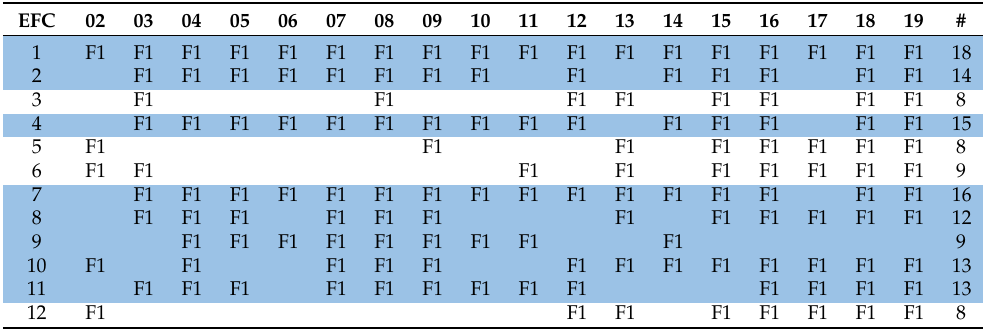
Table 3. Factor analysis, per year, for two factors.